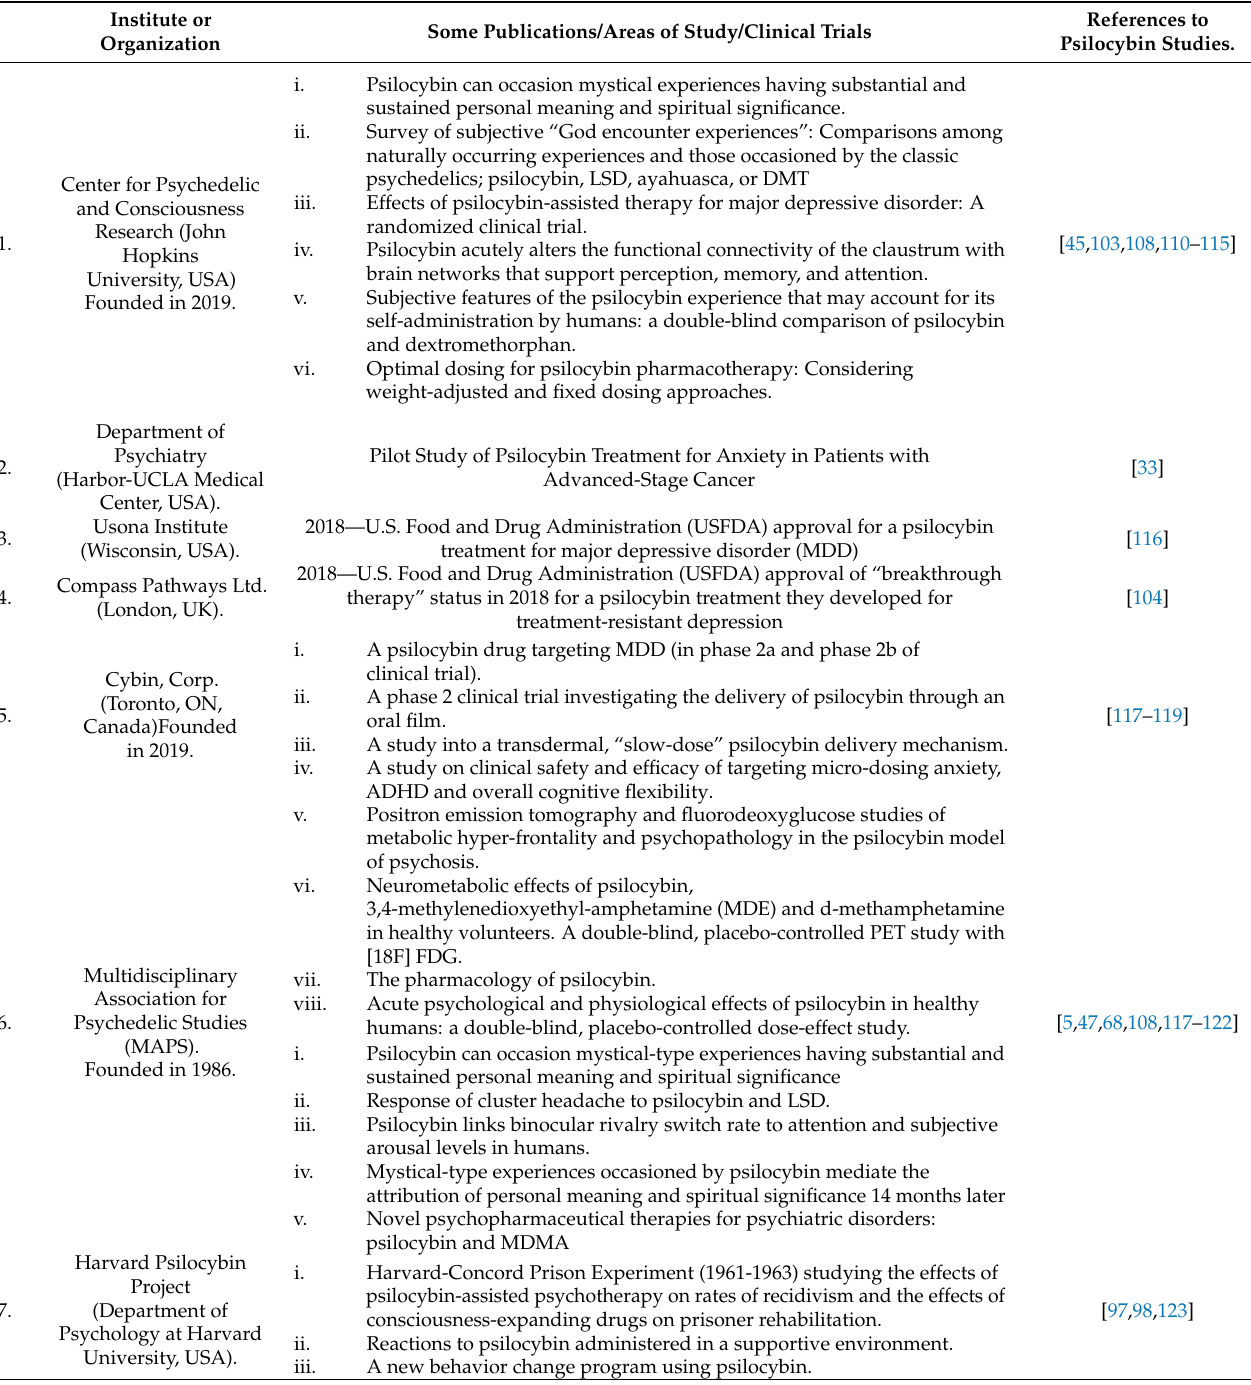
Table 2. Major institutes and organizations involved in psilocybin